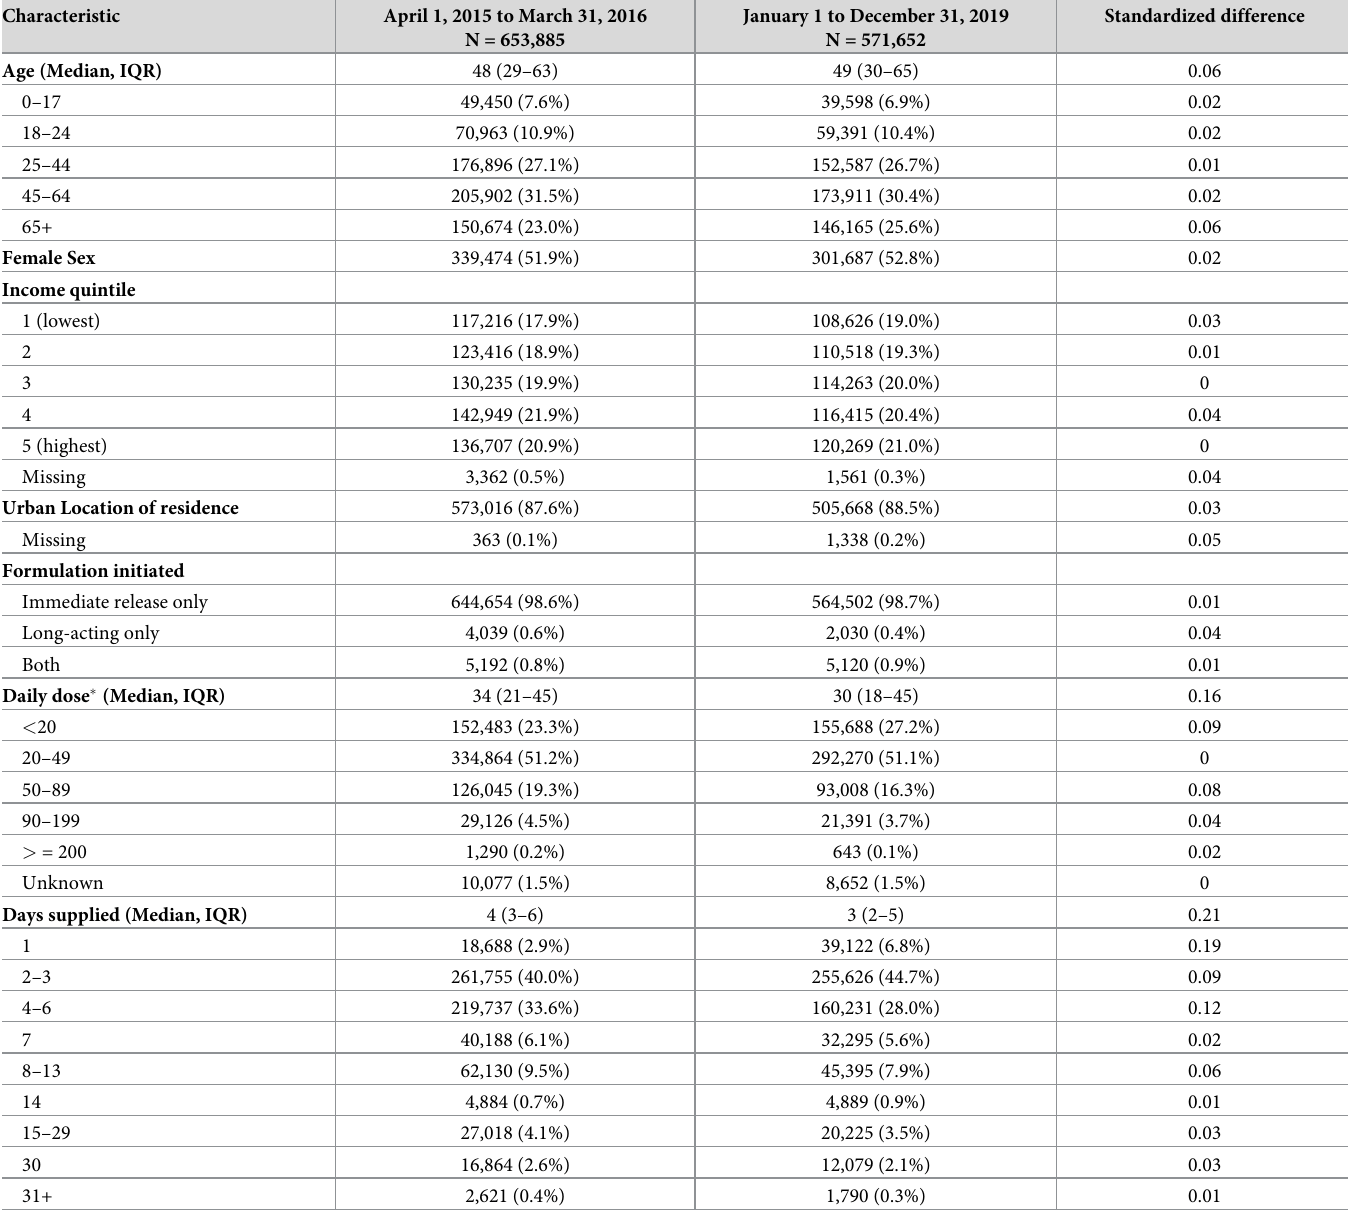
Table 1. Baseline characteristics of new opioid recipients in fiscal year 2015 and calendar year 2019.